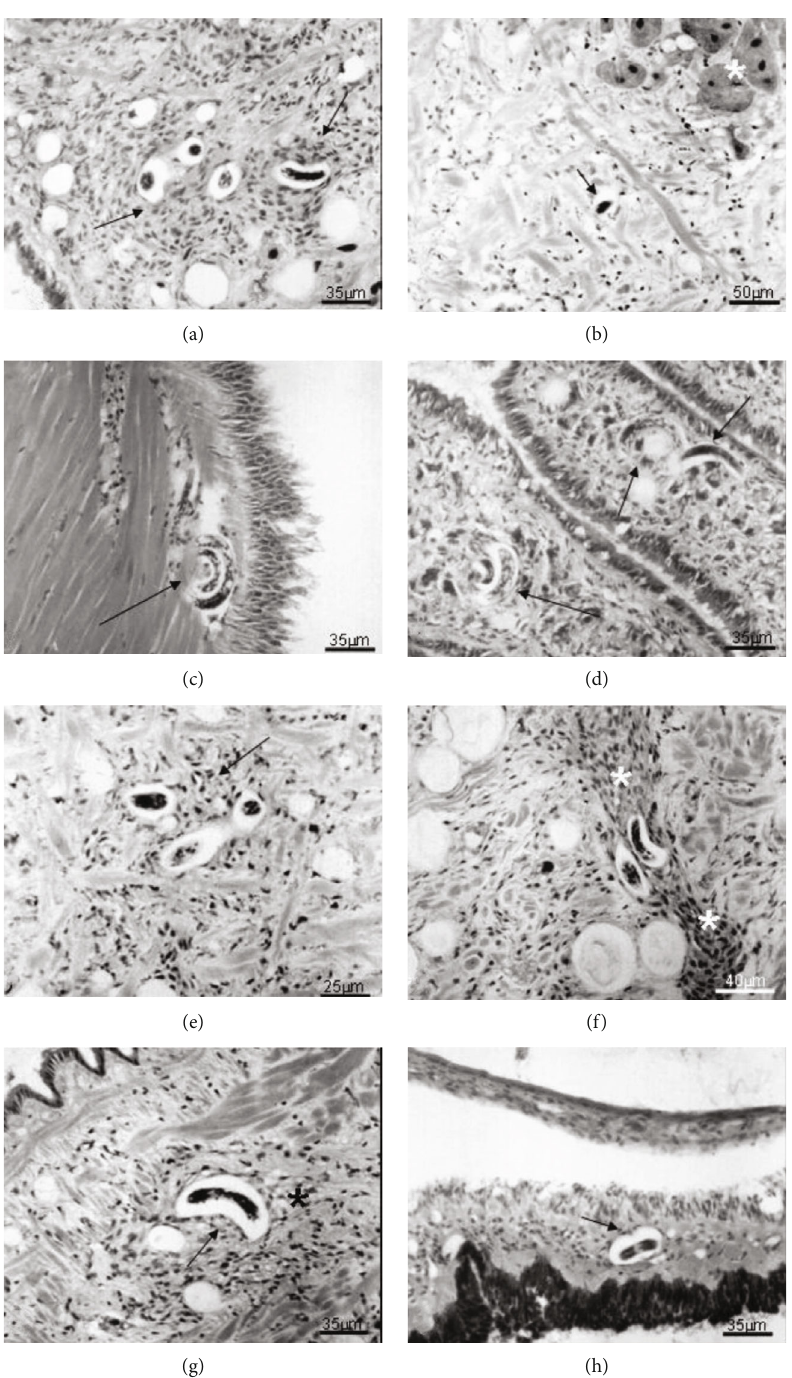
Figure 2: Histological sections of Biomphalaria glabrata infected with 1000 L1 of Angiostrongylus vasorum . Hematoxylin and eosin staining. (a) Larva in the foot fi bromuscular tissue (arrows) presenting a clear space between it and the tissue with cellular in fi ltrate around fi ve hours after the beginning of infection; (b) larvae in foot fi bromuscular tissue with no evident cellular reaction with six hours after beginning of infection. White asterisk shows structures of the nervous system; (c) larva located in the columellar muscle with cellular in fi ltrate close to it; (d) larvae located in the lamellae of pseudobranquia (arrow), showing no cellular reaction, eight hours after the beginning of infection; (e) larvae in foot fi bromuscular tissue (arrow) with evidence of perilarvar reaction more organized, maintaining a clear space of twelve hours after the beginning of infection; (f) intense cellular reaction in the fi bromuscular tissue of dorsalis pedis mass with the presence of a pregranuloma perilarvar (white asterisk) twenty-four hours of the beginning of infection; (g) cell in fi ltration in the fi bromuscular tissue of the dorsalis pedis region (black asterisk) with the starting to form a cell button on the one side of the pregranulomatous reaction (arrow); (h) larva located in the mantle without showing obvious cellular reaction maintaining the standard of formation of a clear space with forty-eight of the beginning of infection. Magni fi cations: (a, c, d, g, and h) 35 μ m; (b) 50 μ m; (e) 25 μ m; (f) 40 μ